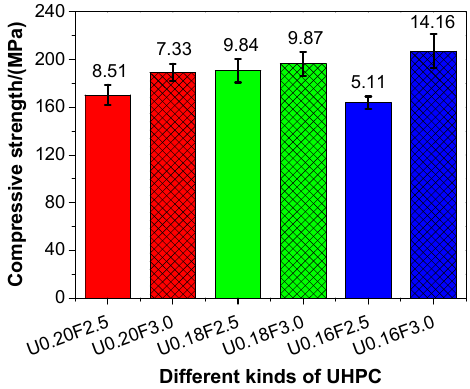
Figure 4. The compressive strength of different kinds of UHPC at 28 days.